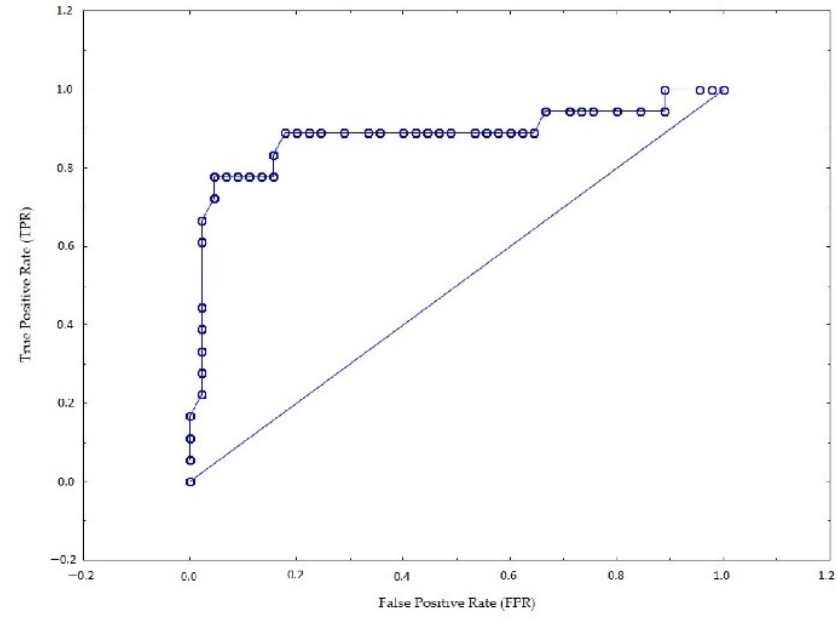
Figure 6. ROC curve for 1st model.